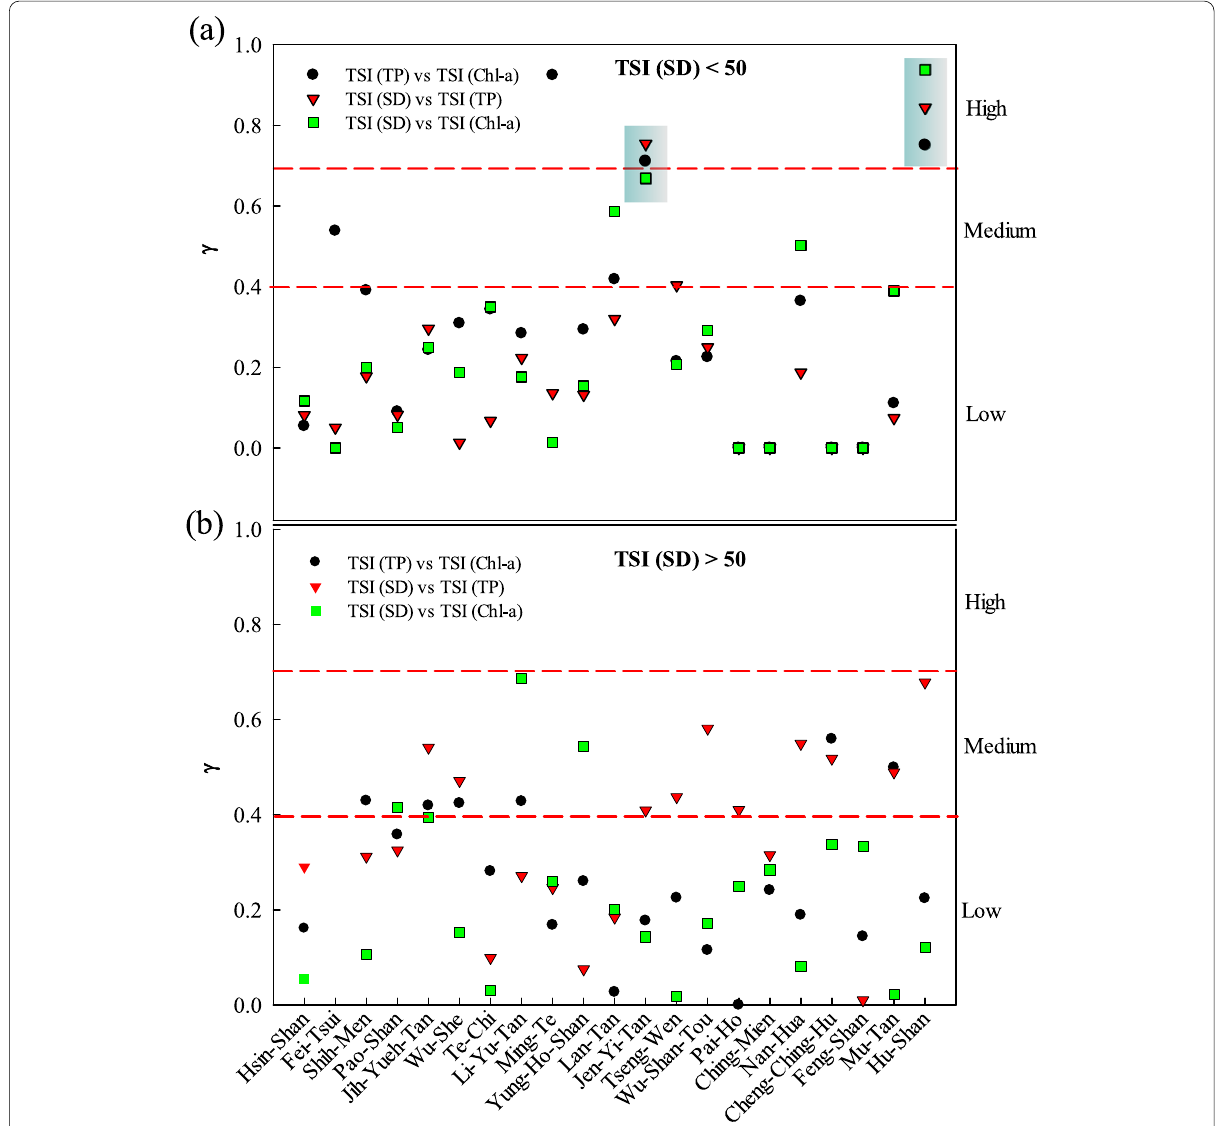
Fig. 8 Pearson correlation between TSI variables at the condition of ( a ) TSI (SD) < 50 and ( b ) TSI (SD) >